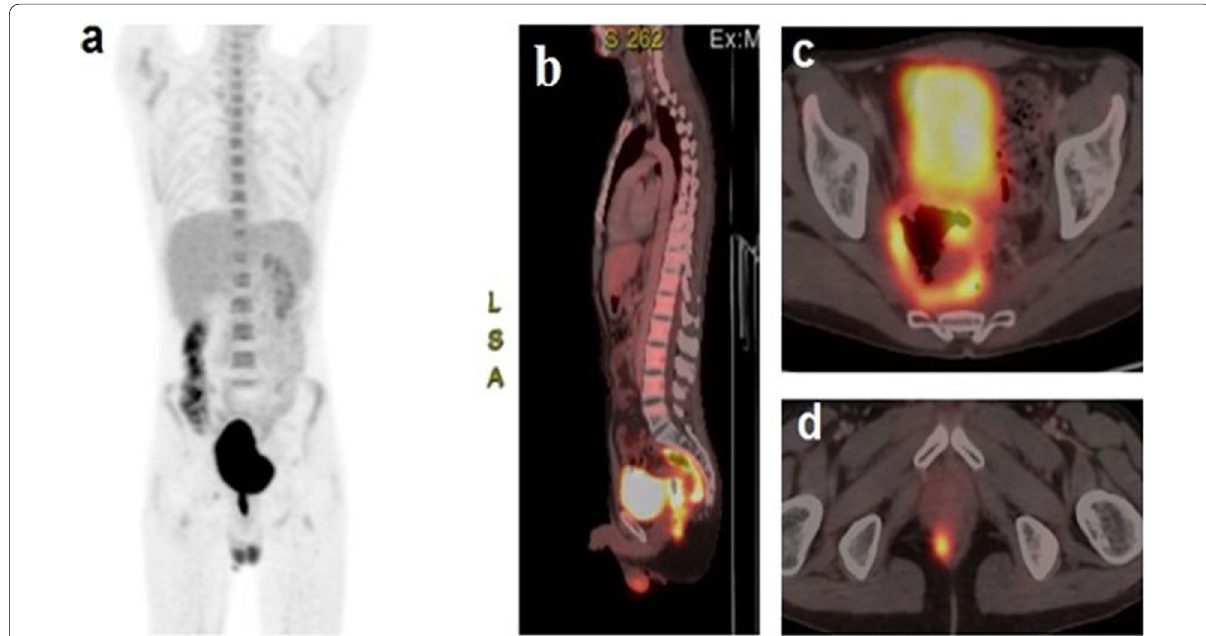
Fig. 9 a–d follow-up PET/CT study for the same patient in Fig. 7. a MIP and b–d fused PETCT images revealed progression in size and metabolic activity of the previously noted metabolically active (FDG avid) circumferential polypoidal mural thickening involving the entire length of the rectum and rectosigmoid junction measuring about 2.2 cm at max thickness and 13 cm at max length with max SUV R 22.8 (compared to 17.26 previously). The lesion now extends to the anal canal blending with the previously noted right sided anal soft tissue nodule. It is seen that intimately related to the posterior wall of the urinary bladder with no definite signs of invasion. Low grade metabolically active right inguinal lymph node is still seen unchanged measuring about 1 cm with max SUV R